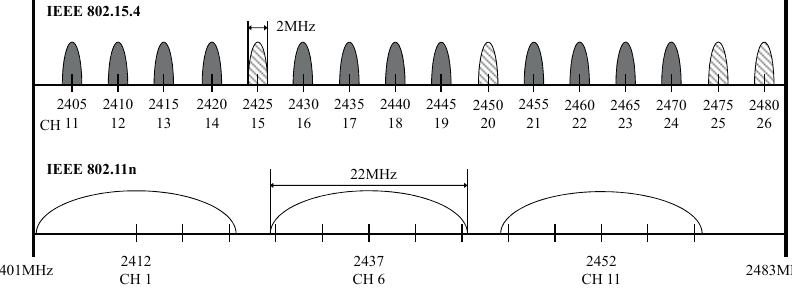
Figure 9. Spectrum comparison between IEEE 802.15.4 and